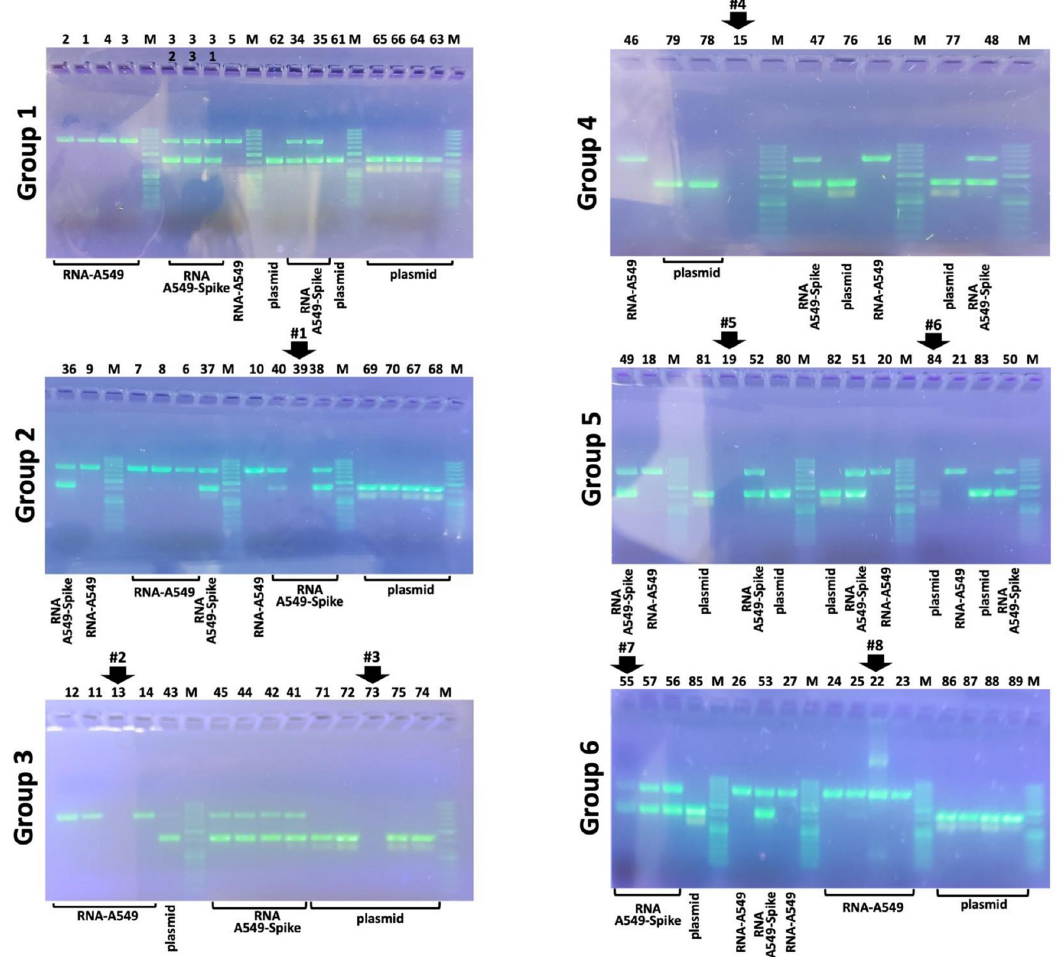
Fig 5. Multiplex PCR amplifying Spike SARS-CoV-2 and β -actin sequences and performed on pCMV3-GFP-Spike plasmid, and cDNA obtained using RNA isolated from untreated A549 cells or A549 cells transfected with the pCMV3-GFP-Spike plasmid, as indicated. The analysis was conducted by the participating 89 students with good results, except for students 39 (Group 1), 13 and 73 (Group 3), 15 (Group 4), 19 and 84 (Group 5), 22 and 55 (Group 6). Notably, students 22 and 55 failed to obtain positive results also when performing gel electrophoretic analysis of the pCMV3-GFP-Spike plasmid and the RNA produced by A549 cells (see Fig 4). The raw uncropped images are included in the S6